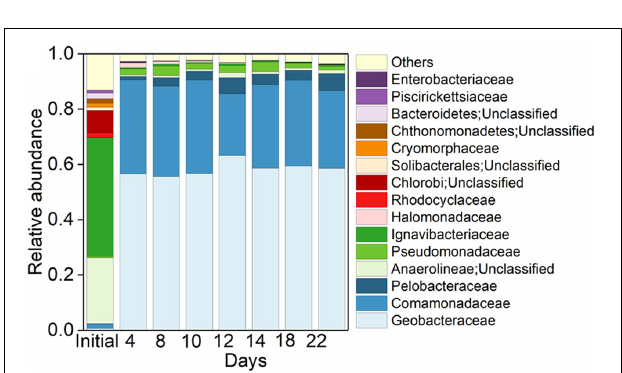
FIGURE 3 | Pattern of microbial community in treatments. Top 15 taxa at family level in the initial Anammox inoculant and the Anammox inoculant-based treatment of Fe(III) + NH 4 + during the 22-day incubation.